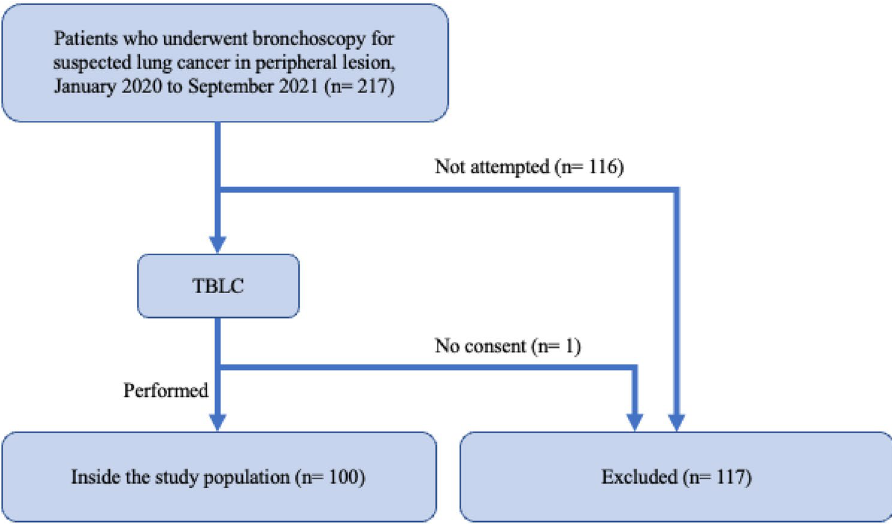
Figure 1. Flow diagram displaying patient selection.